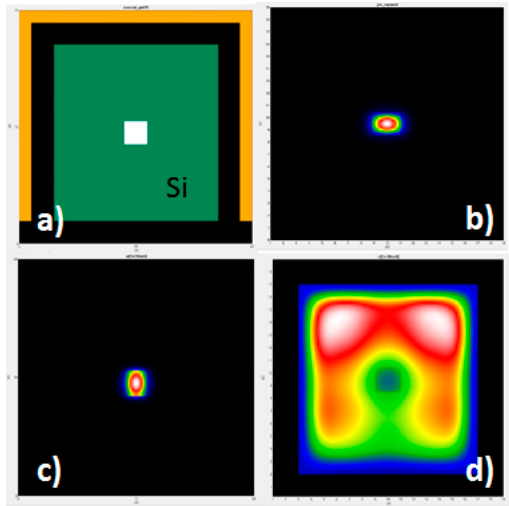
Figure 18. Two-dimensional quantum mechanical device simulation. Schema of the nMOSFET with channel width and height of 20 nm ( a ). The channel (green) is unstrained silicon with a dislocation (2nm × 2 nm) in the center (white). Gate oxide and BOX are drawn in black, while the gate electrode is shown in yellow. The first wave function is localized in the dislocation if uniaxial tensile strain ( ε = +0.1) is applied ( b ). Electron densities for devices with a dislocation in the center ( c ) and an unstrained Si channel ( d ). Red means the highest and black the lowest electron densities. The gate voltage is V G = 0.5 V.